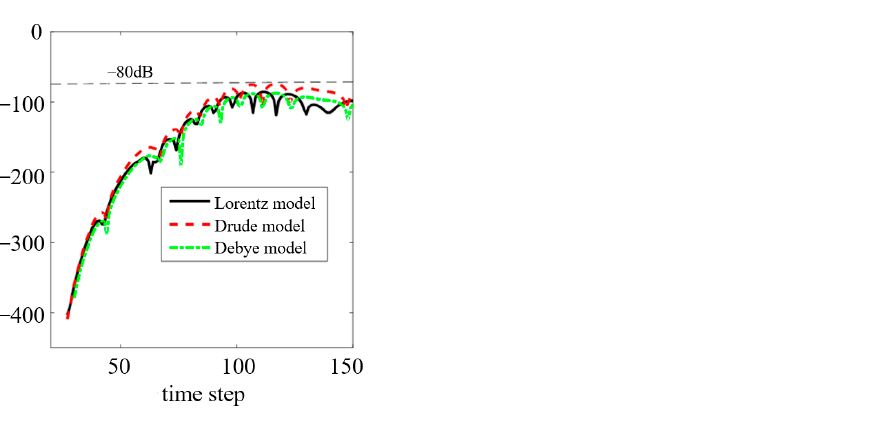
Figure 2. The reflection relative error of CPML in the three dispersion models.